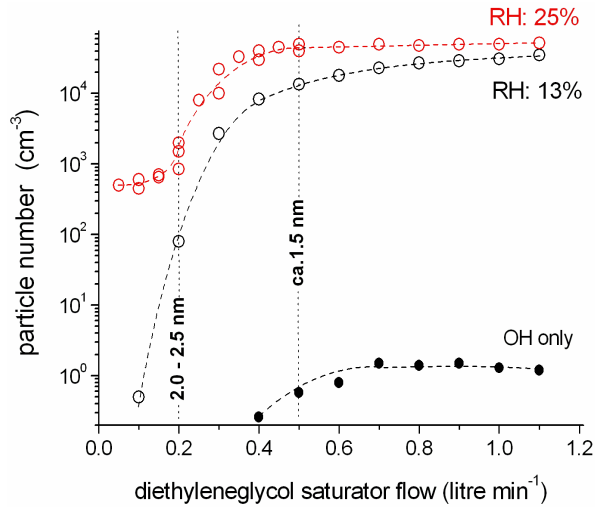
Fig. 6. Cumulative size distributions from PSM measurements (by scanning the diethyleneglycol flow) for a dimethylamine concen- tration of 1 . 1 × 10 9 moleculecm − 3 at a relative humidity of 13 and 25%. The data for “OH only” have been obtained under conditions with OH radical formation in the absence of added amine and SO 2 representing a background measurement. Dotted lines show the di- ethyleneglycol flow settings as used in the measurements for parti- cles with a diameter ≥ ca. 1.5nm or particles with a diameter ≥ 2.0–